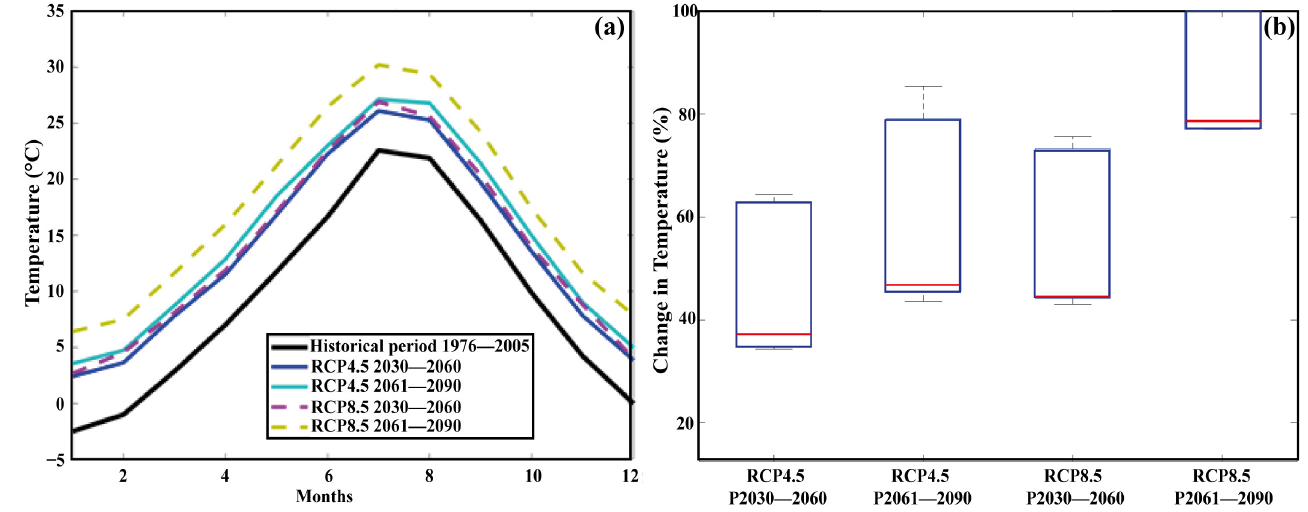
Figure 8. Future projected daily temperature ( a ) and future changes in temperature by scenario and period ( b ).